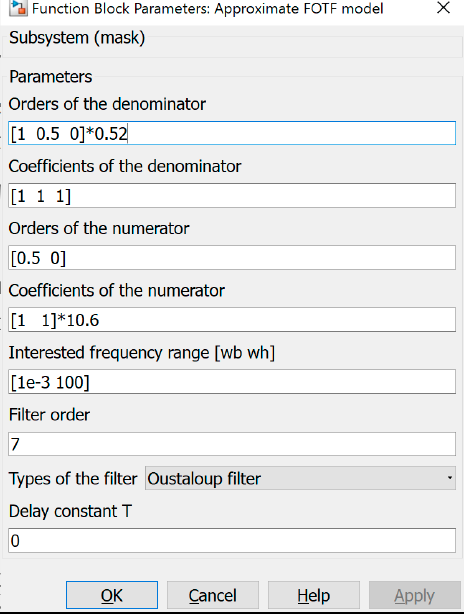
Figure 12. Parameters of the FOTF block from Figure 11.